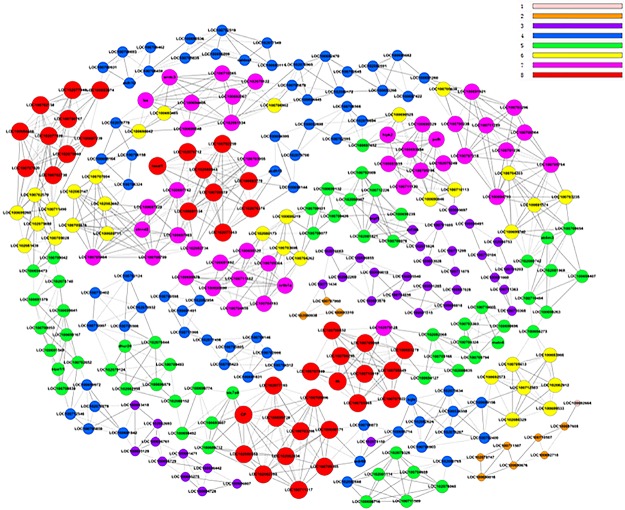
Co-expression network of differentially expressed genes in freshwater and 16 psu.The greater the value of k-core is, the more strongly the differentially expressed genes are co-expressed according to the size of the ball. The labels from one to eight represent the importance of genes. The red represents the most significant and the pink means the least significant.